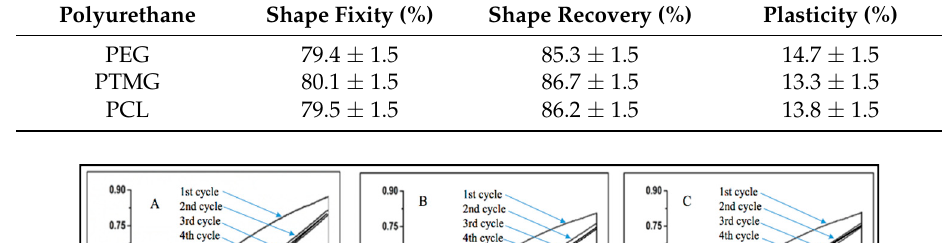
Figure 11. Thermo-mechanical cyclic curves of ( A ) Polyethylene Glycol (PEG); ( B ) Polycaprolactone (PCL); ( C ) Polytetramethylene Glycol (PTMG). Table 3. The shape memory properties of the different polyurethanes.